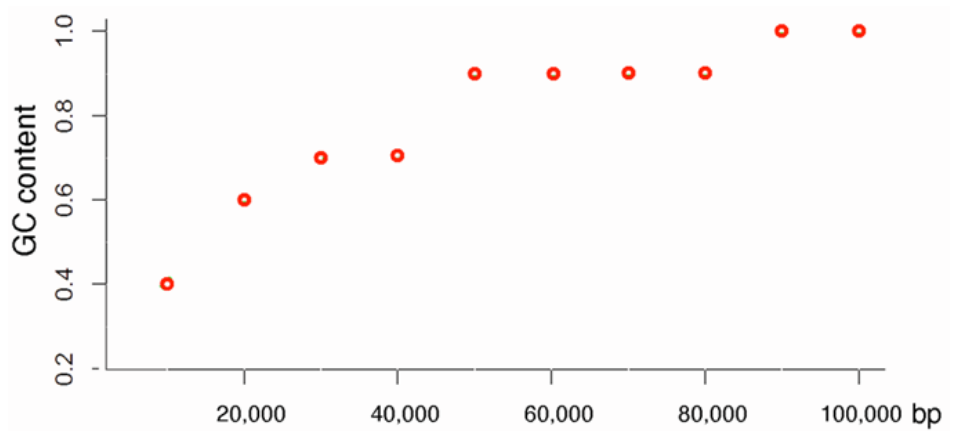
Figure 1. Identifying an “isochore” where none exists by the algorithms of Cozzi et al. and Costan- tini et al. [12,13]. According to both algorithms, chromosomal sequences are first “partitioned into non-overlapping 100-kb windows.” In the next step, the GC level is calculated as the mean GC content within the “window.” Let us assume that the sequence above represents one such window, and that the GC contents within its ten 10 kb nonoverlapping sub-windows vary, as shown. The variation will be ignored by the algorithms and the entire 100 kb window will be deemed to be an “isochore” with a mean GC content of 0.8, even though none of the sub-windows has such a GC content. A “new-and-improved” algorithm by the isochore proponents, isoSegmenter, was put forward by Cozzi et al. [13]. isoSegmenter goes a step further than [12] by making sure that exactly five isochore families will be identified whether they exist or not. In contrast to [12], in which the number of isochore families is not predetermined, isoSegmenter leaves nothing to chance. isoSegmenter partitions the genome into non-overlapping 100 kb-length windows and does not pay attention to the compositional variation within each segment. Next, the GC content is computed for each window and, based on the GC content, the window is assigned to one of five predetermined isochore families, as dictated by [18]: